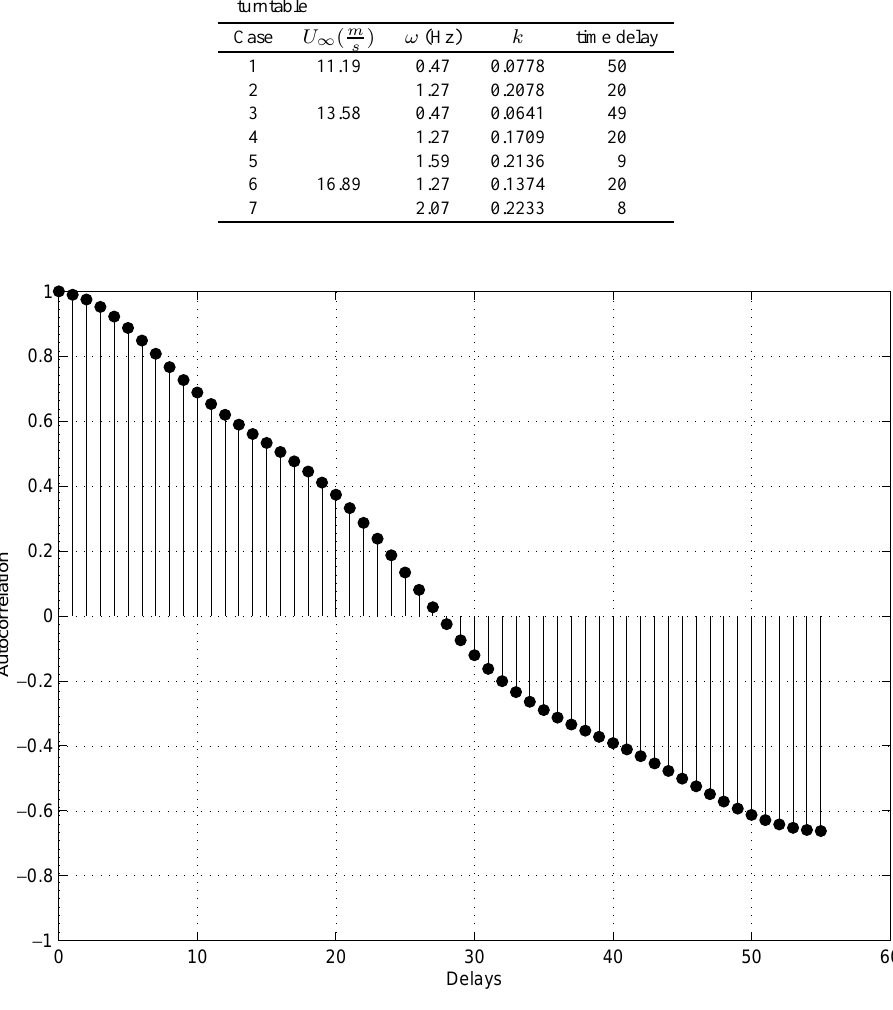
Table 1 Parameters of bending measurements for oscillating